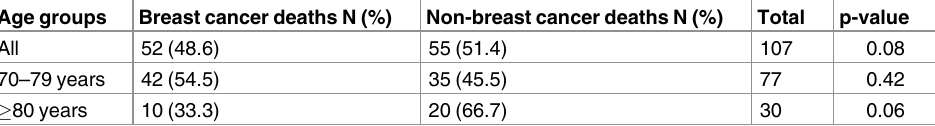
Table 3. Causes of death by age groups in older women with ER-negative early operable primary breast cancer.